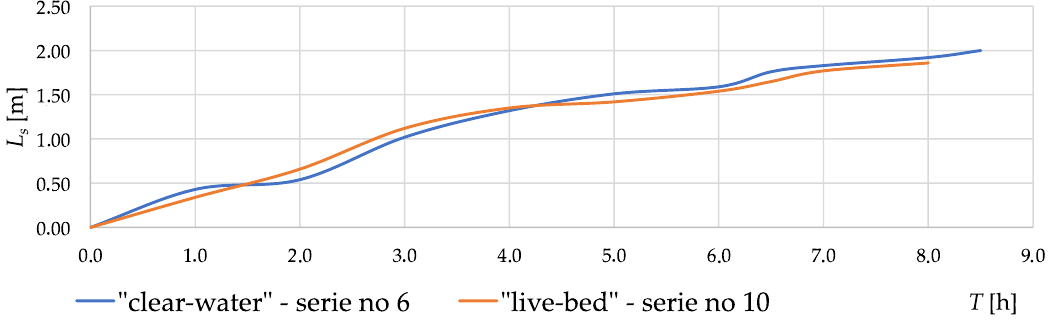
Figure 14. Local scour length evolution in time.